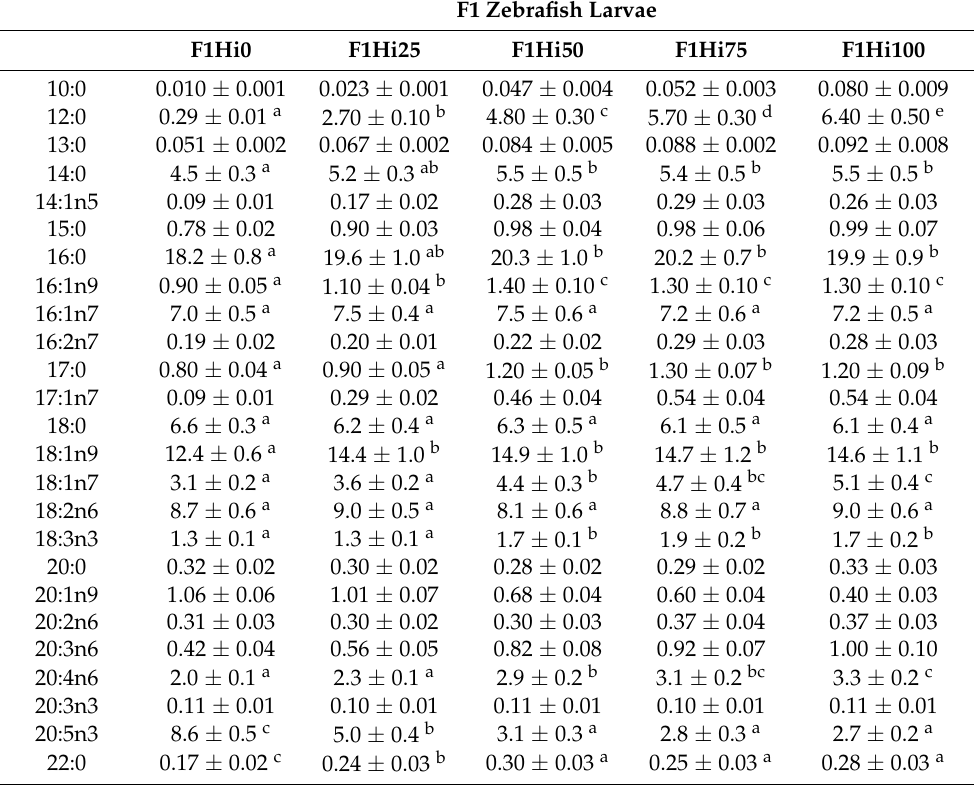
Figure 2. ( a ) Content of saturated fatty acid (SFA), monounsaturated fatty acid (MUFA) and polyunsaturated fatty acid (PUFA) (as % of total fatty acids ) and omega 3 ( n -3), omega 6 ( n -6), omega 9 ( n -9) fatty acid contribution to lipid profile and ( b ) n6/n3 ratio of F1 zebrafish larvae fed the different experimental diets (F1Hi0, F1Hi25, F1Hi50, F1Hi75 and F1Hi100). a–e Different letters show statistically significant differences among experimental groups compared within the same FA class ( p < 0.05). Values are reported as mean ± standard deviation ( n = 3). Table 3. Fatty acid composition (as % of total FA) and DHA/EPA ratio of F1 zebrafish larvae. F1 Zebrafish